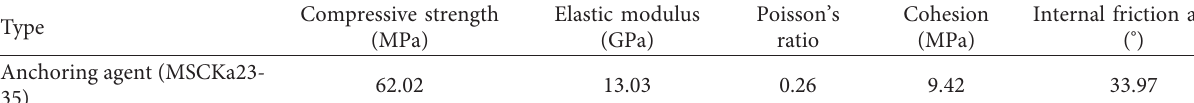
Table 3: Summary of mechanical parameters of anchoring agent used in the Wudong coal mine. Type Anchoring agent (MSCKa23-